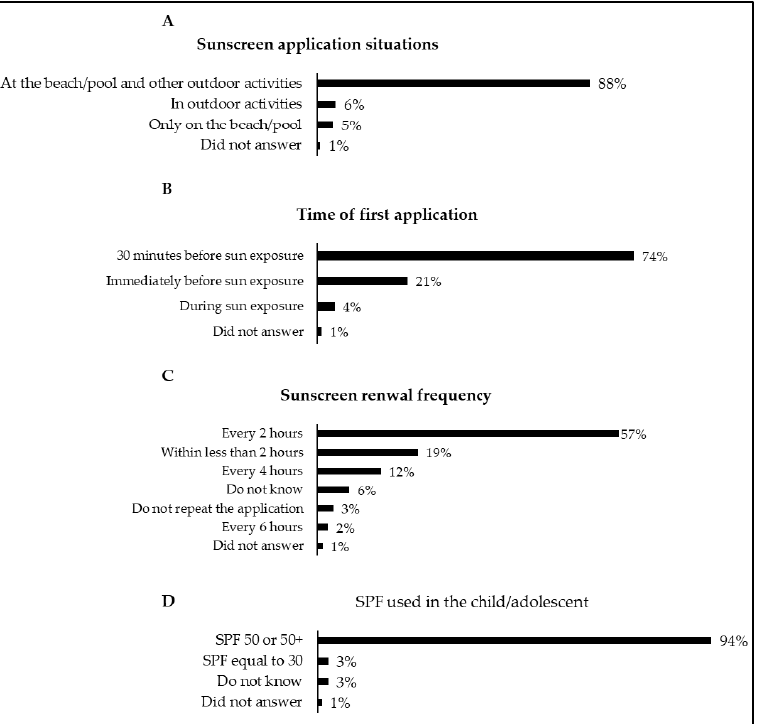
Figure 6. Sunscreen application situations ( A ), time of first application ( B ), sunscreen renewal frequency ( C ), and sun protection factor (SPF) used in the child/adolescent ( D ). In the last 12 months, it was reported that 90% of children/adolescents did not suffer sunburn after sun exposure, while 8% suffered only one sunburn. In addition, 2% of caregivers answered that they did not know if the children/adolescents had suffered a sunburn in the last 12 months. Finally, 88% of caregivers answered that there was no case of skin cancer in the family, while 5% reported a case, and 7% said they did not know. 3.6. Educational Level vs. Caregivers ’ Knowledge Regarding Exposure and Sun Protection in Children and Adolescents There was a significant relationship ( p < 0.001) between self-knowledge about sun protection and the total knowledge score with education level. In general, caregivers who reported not having self-knowledge about sun protection and presented lower total knowledge scores were those with a lower level of education or even none. In addition, most caregivers who agreed with the following statements presented a lower level of education or no level of education: “ 3. There is no need to use sun protection measures during the winter months ” ; “ 4. At the beach and pool, it is enough to put on sunscreen once ” ; “ 7. The proper time to apply the protector is on arrival at the beach ” ; “ 10. It is only necessary to use sunscreen at the beach or pool ” ; and “ 11. People with dark skin do not need to take special care when they are in the sun ” . 3.7. Knowledge vs. Attitudes of Caregivers Regarding Exposure and Sun Protection in Children and Adolescents There was a significant association ( p < 0.05) between the statement “ 3. There is no need to use sun protection measures during the winter months ” and the frequency of use